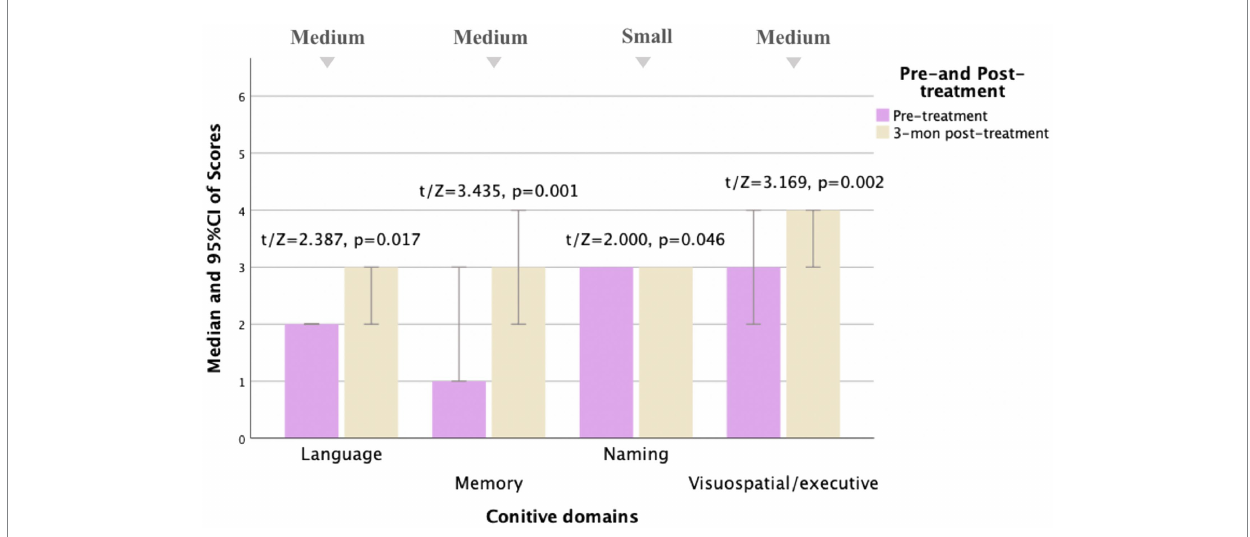
FIGURE 2 Comparison of MoCA subscale scores pre- and 3 months post-treatment for MD patients ( N = 30). Compared to pre-treatment, MoCA subscale scores improved mainly in language, memory, naming, and visuospatial/executive aspects ( t /Z = 2.387, 3.435, 2.000, and 3.169, and p < 0.05) at 3 months post- treatment, especially in memory and visuospatial/executive aspects ( p < 0.01). Small, medium, and large indicate clinically meaningful Cohen d effect sizes.